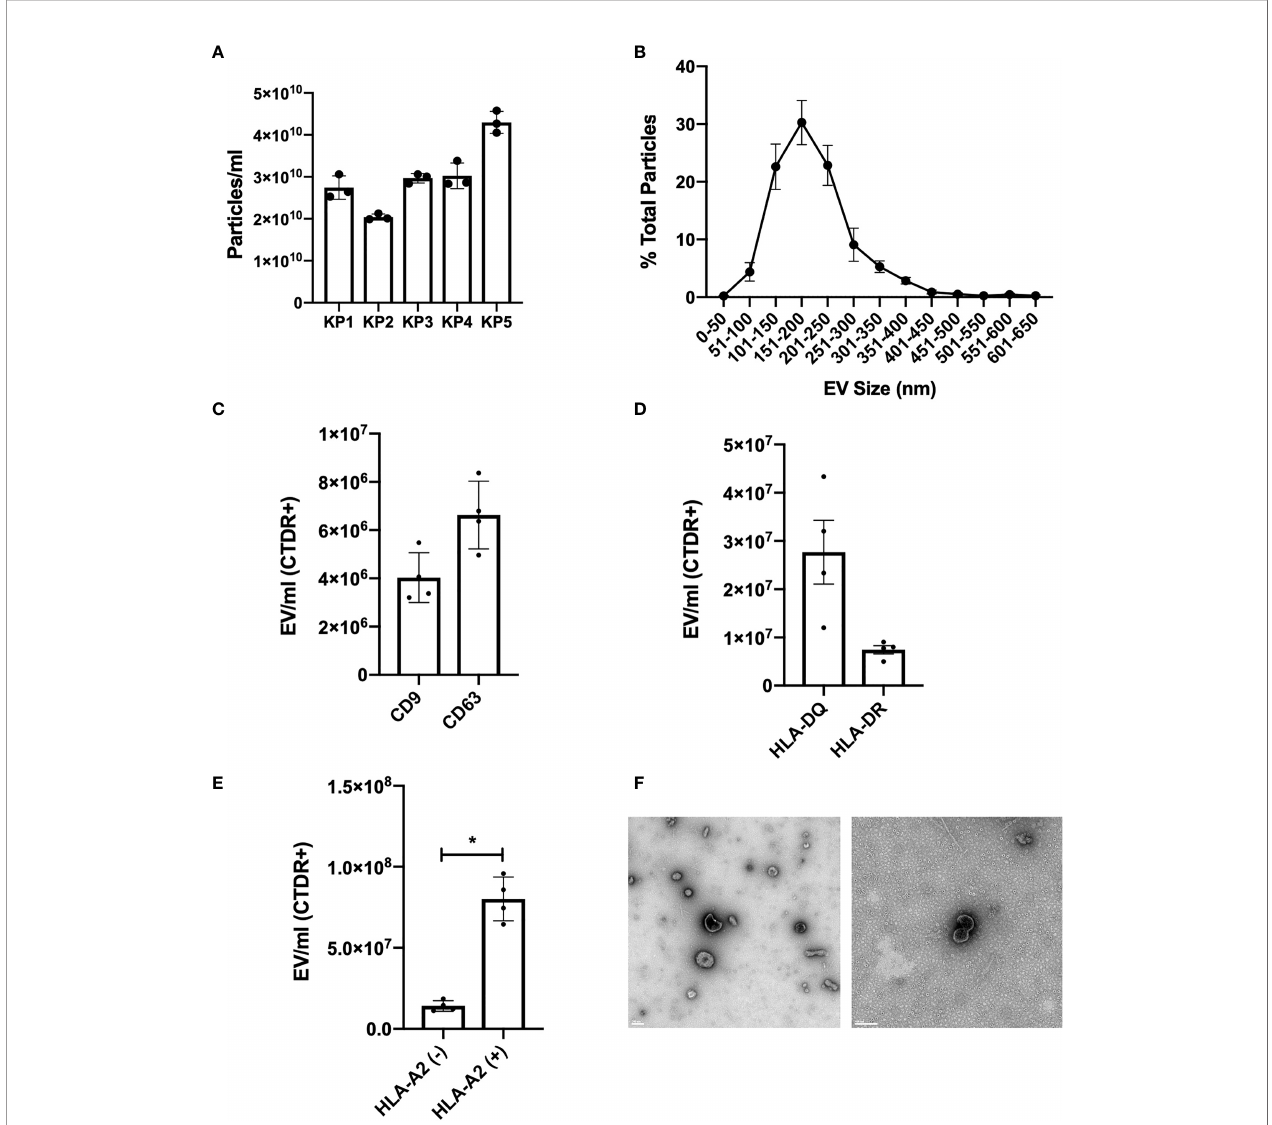
FIGURE 1 | Characterization of KP-EV in human donor kidney perfusion fl uid samples. (A) Quanti fi cation and (B) size distribution of kidney perfusion fl uid particles by nanoparticle tracking analysis (n=5). (C) KP-EV CD9-PE and CD63-PE expression quanti fi cation by Cyto fl ex (n=4). (D) KP-EV HLA-DR-BV421 and HLA-DQ-PE expression quanti fi cation by Cyto fl ex (n=4). (E) HLA-A2-PE expression of KP-EV derived from HLA-A2 negative donors (n=4) and HLA-A2 positive donors (n=4) by Cyto fl ex. (F) Representative transmission electron microscopy images of KP-EV enriched fractions by whole mount negative staining. Each image represents EV from a different human kidney donor. LEFT: scale bar: 200 nm, magni fi cation: 13 000X. RIGHT: scale bar: 100 nm, magni fi cation: 50 000X. *represents p-values